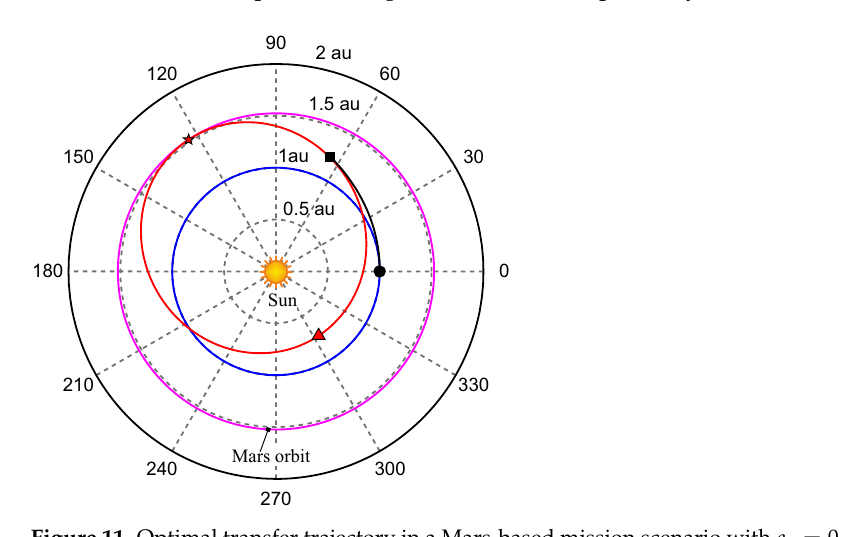
Figure 11. Optimal transfer trajectory in a Mars-based mission scenario with e f = 0.3438 and β =